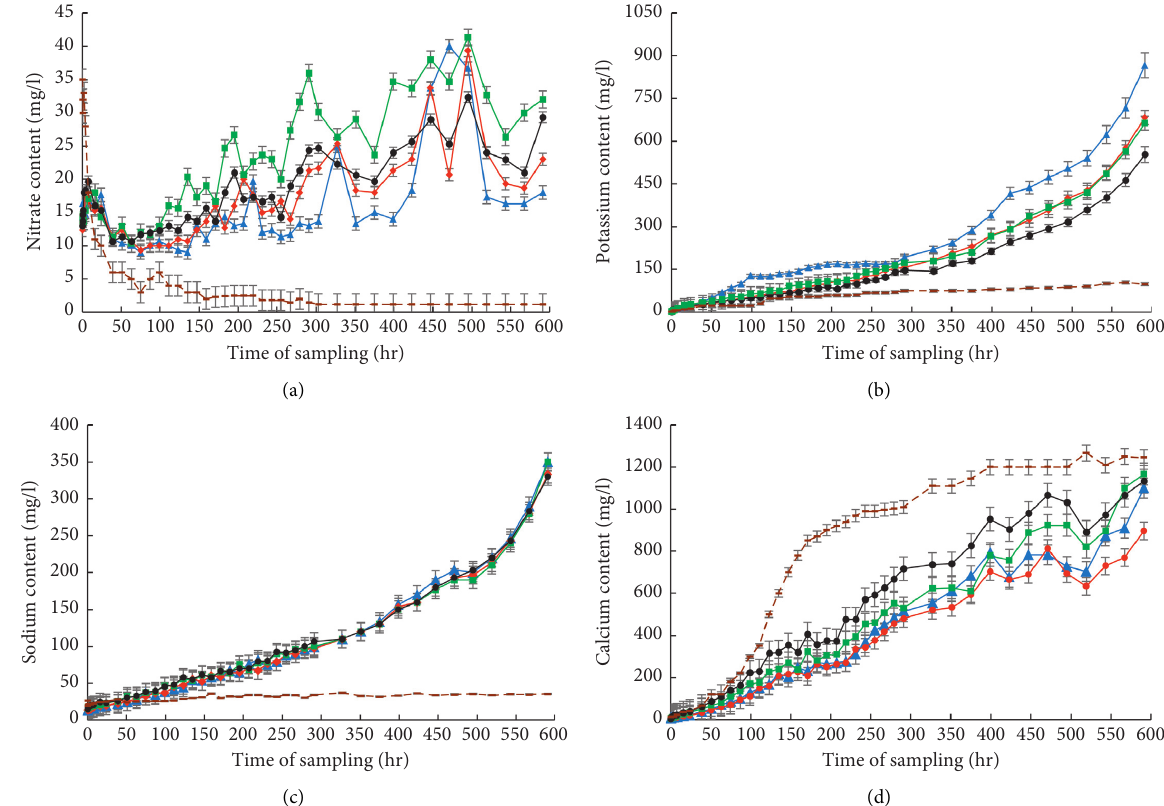
Figure 2: Release of potassium, sodium, nitrate, and calcium contents of solid vermicast-inoculated biochar (solid line, green square), vermicast tea-inoculated biochar (solid line, red rhombus), deionized water-inoculated biochar (solid line, blue triangle), biochar alone (solid line, black round), and Promix-BX alone (broken line, brown dash) in deionized water. Vertical lines represent standard error